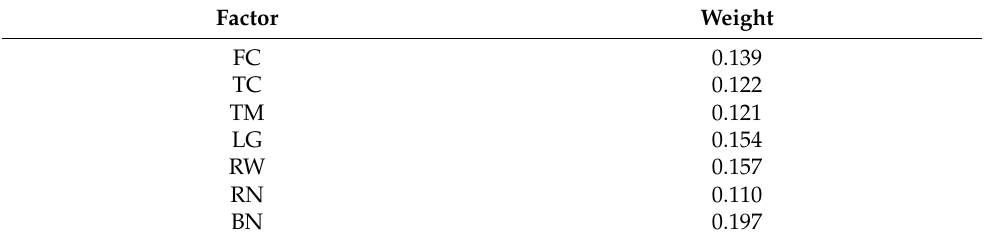
According to Formula (9), using the mean value Ex and the cloud entropy En to optimize the weight obtained by the entropy weight method in Section 3, the optimized weights are shown in Table 6: Table 6. The factors